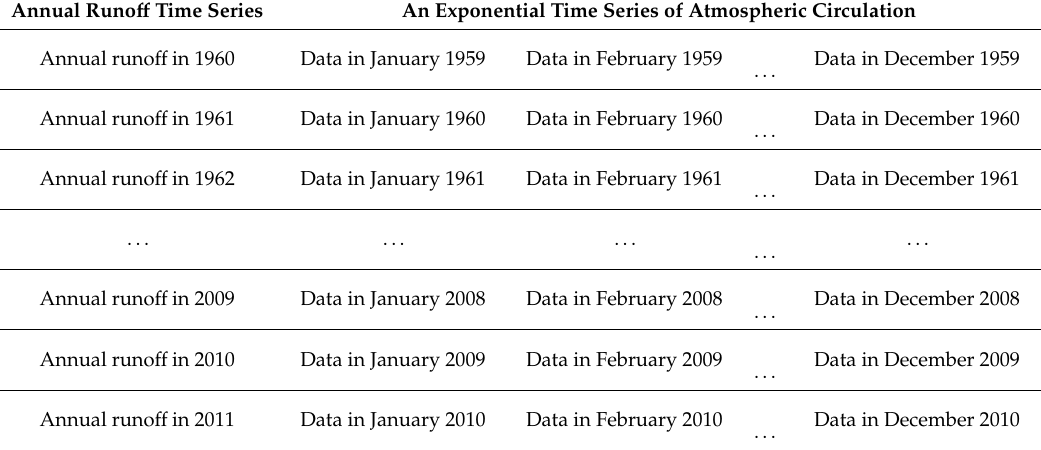
Table 1. The corresponding relationship between the time series of a certain atmospheric circulation index and the runo ff time